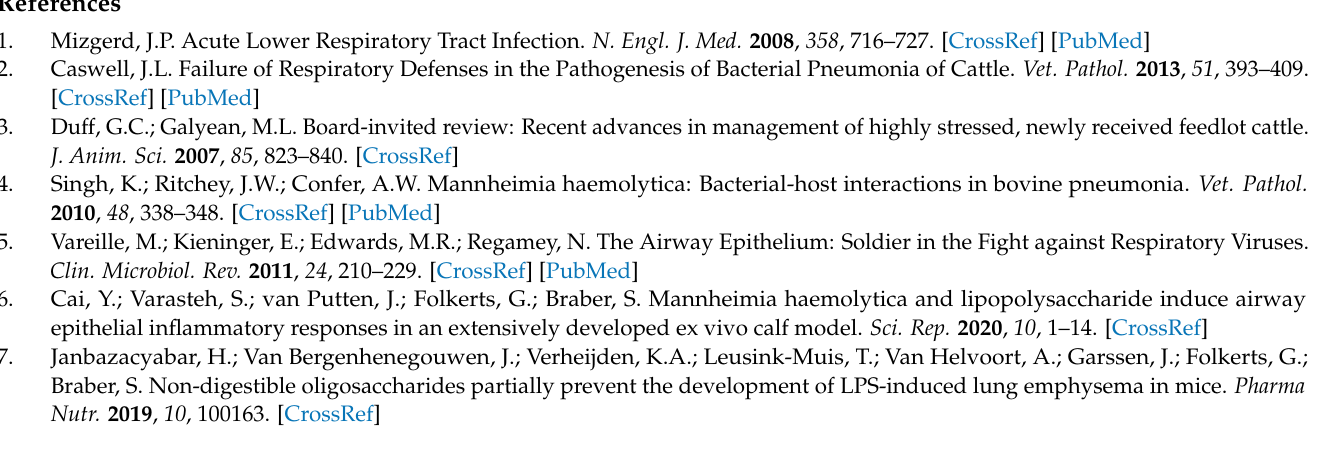
Figure S2: Effect of FOS on MHS-induced inflammation in PBECs, Figure S3: Anti-inflammatory effects of FOS in LPS- or flagellin-treated human airway epithelial cells, Table S1: The number of calves per treatment and parameter, Table S2: The number of calves positive for M. haemolytica in BALF over